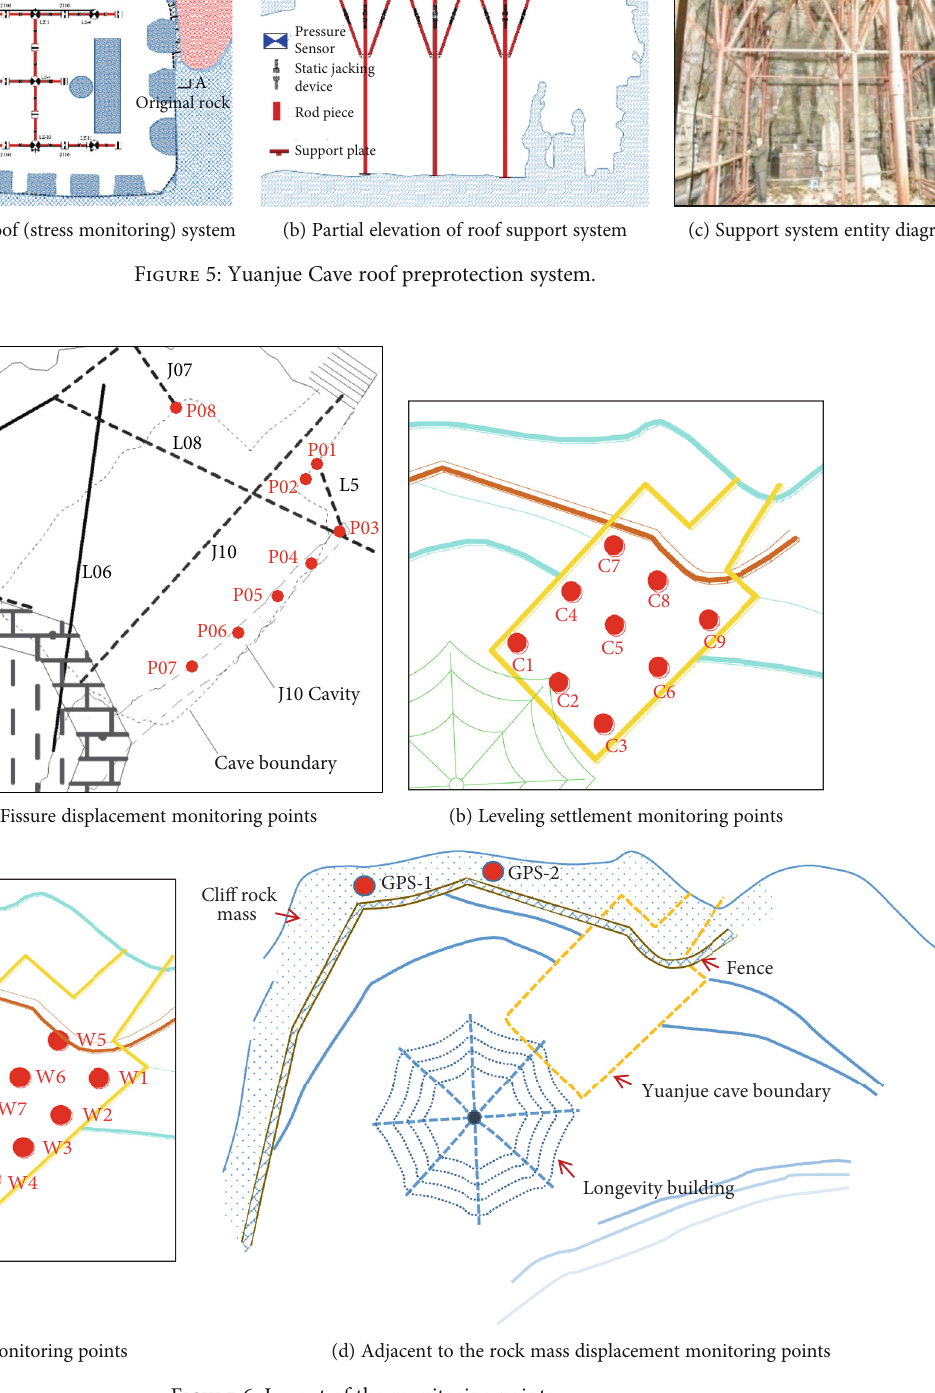
Figure 6: Layout of the monitoring